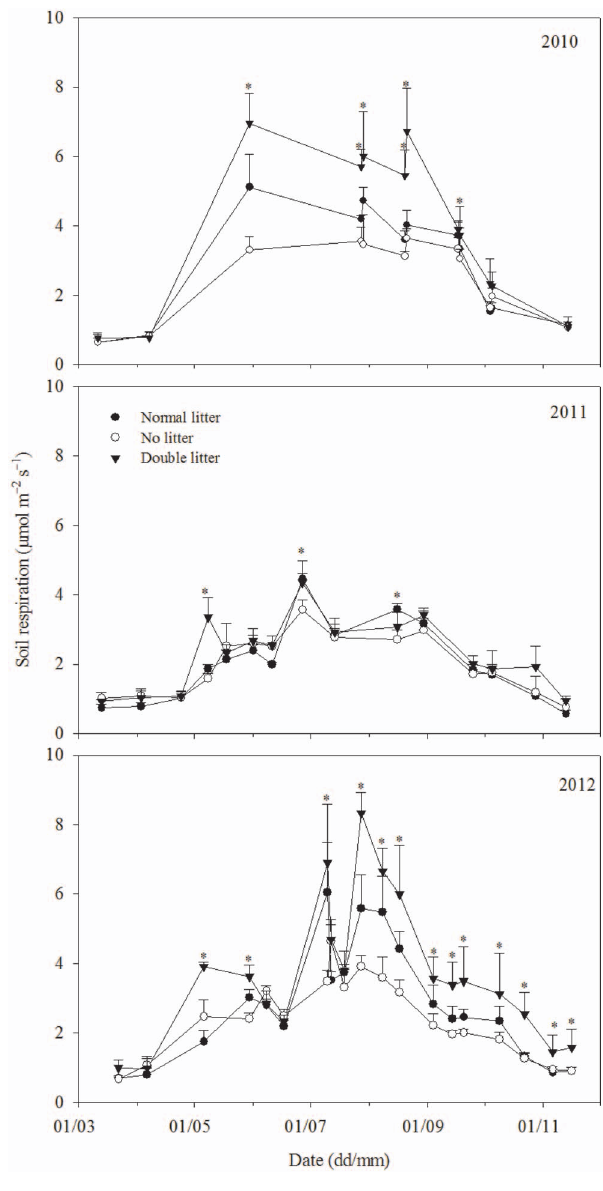
Figure 4. Variation in soil respiration ( m mol m 2 2 s 2 1 ) under normal litter, no litter, and double litter treatments in 2010, 2011, and 2012, respectively. The asterisk indicates a significant difference at P ,